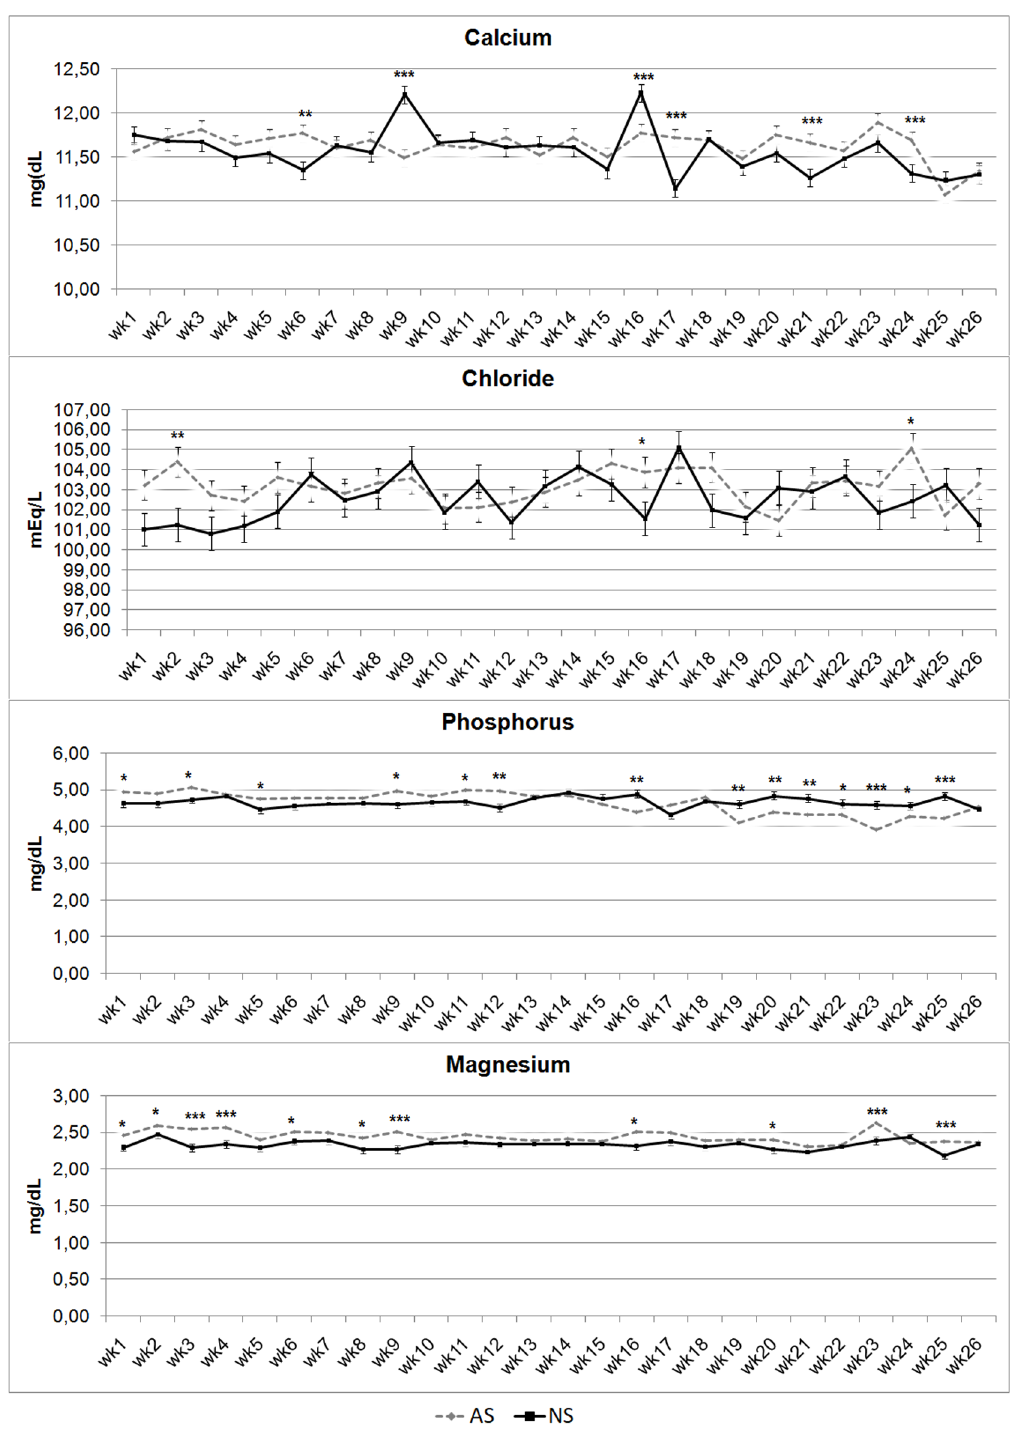
Fig 7. Calcium, chloride, phosphorous and magnesium serum concentrations in artificially-suckled (AS) and naturally- suckled (NS) donkey foals during the first 26 weeks of life. (Values are Least Square Means; bars represents Standard Error of the Mean). Statistical differences between the two groups at the same week were expressed: (cid:3) = P < 0.05; (cid:3)(cid:3) = P < 0.01; (cid:3)(cid:3)(cid:3) = P < 0.001.